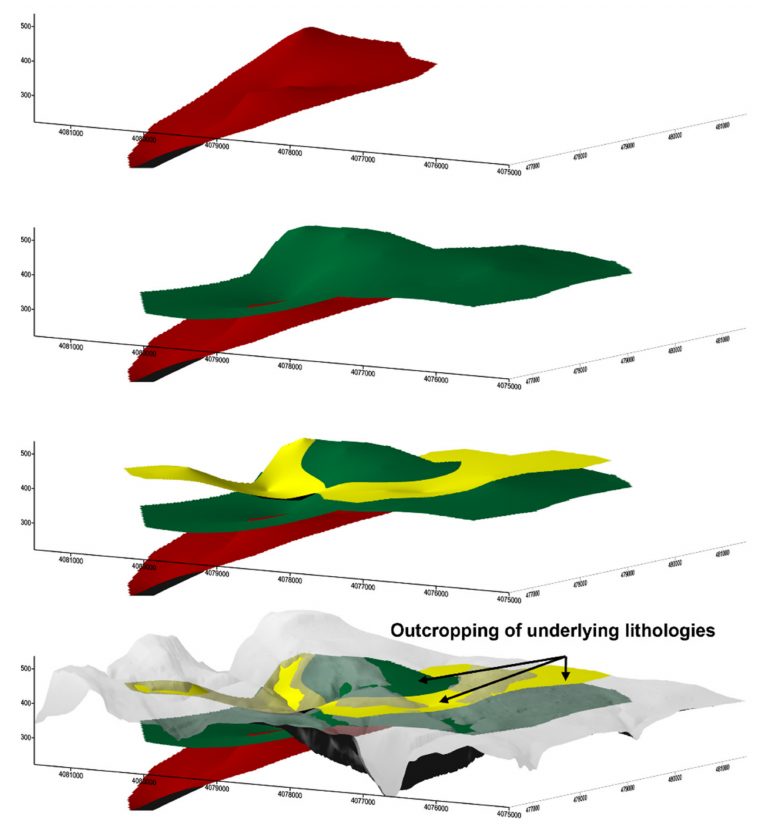
Figure 9. 3D imaging of the seismo-stratigraphic boundaries in the subsoil of